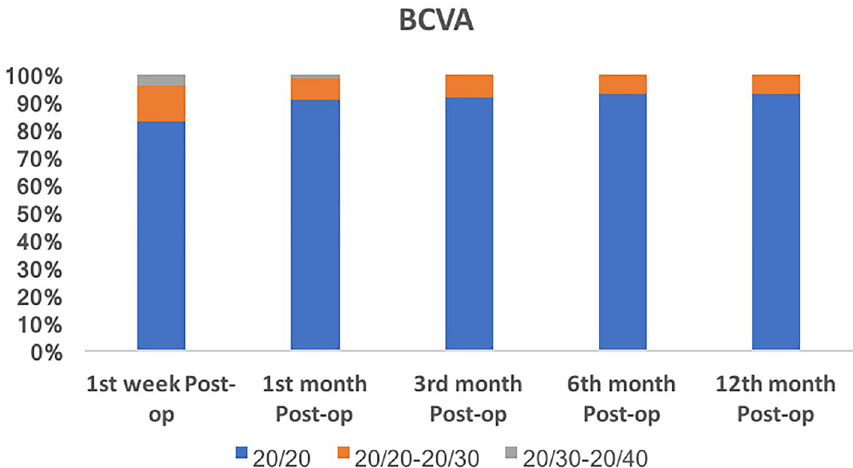
Figure 3. Time course of changes in the best corrected visual acuity (BCVA).